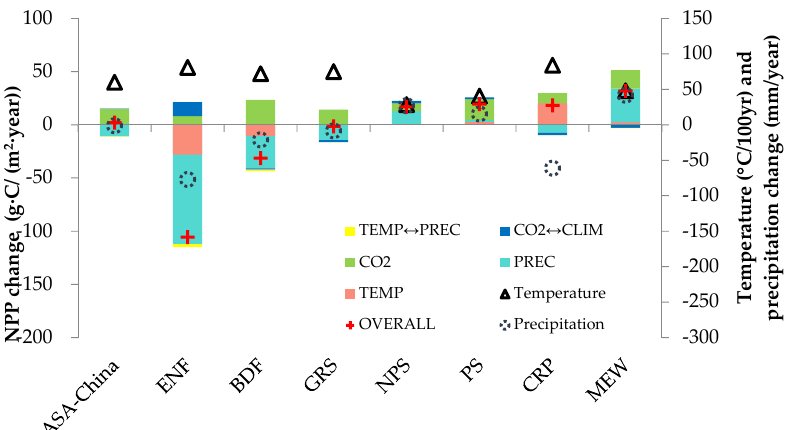
Figure 5. Different climate/CO 2 change effects on the NPP of ASA ‐ China and the major PFTs. CO 2 : CO 2 change effect; TEMP: temperature change effect; PREC: precipitation change effect; TEMP ↔ PREC: interactive effect between TEMP and PREC; CO 2 ↔ CLIM: interactive effect between CO 2 and climate changes; OVERALL: the overall effects of all climate and CO 2 changes. Major PFTs: evergreen needleleaf forest (ENF), broadleaf forest (BDF), phreatophytic shrubland (PS), non ‐ phreatophytic shrubland (NPS), grassland (GRS), cropland (CRP) and meadow (MEW). “Temperature” shows the mean temperature change (by comparing the mean temperature during the 1980–1997 period and that of 1997–2014) in the analysis region (e.g., the areas where a certain PFT is distributed); similarly, “Precipitation” shows the mean precipitation change in the analysis region.